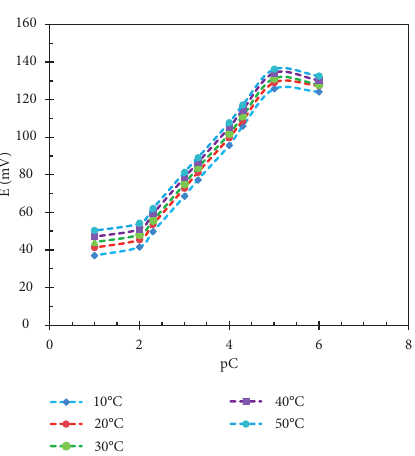
Figure 6: Effect of temperature on MON.Cd. sensor response.